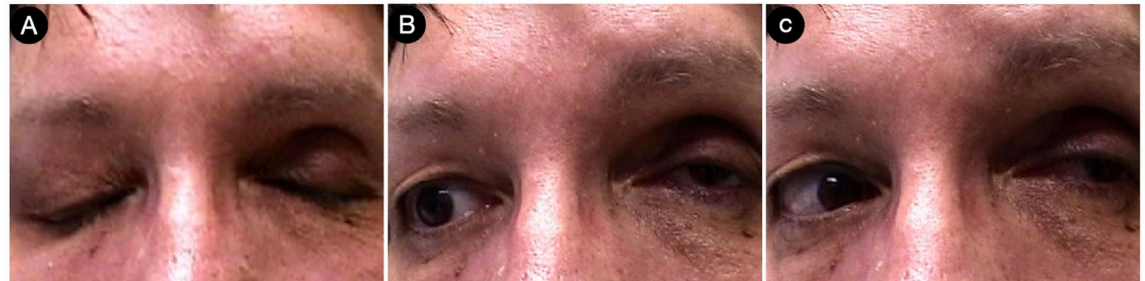
Figure 18. ( A – C ) Postoperative pictures of the patients, showing the oculomotor